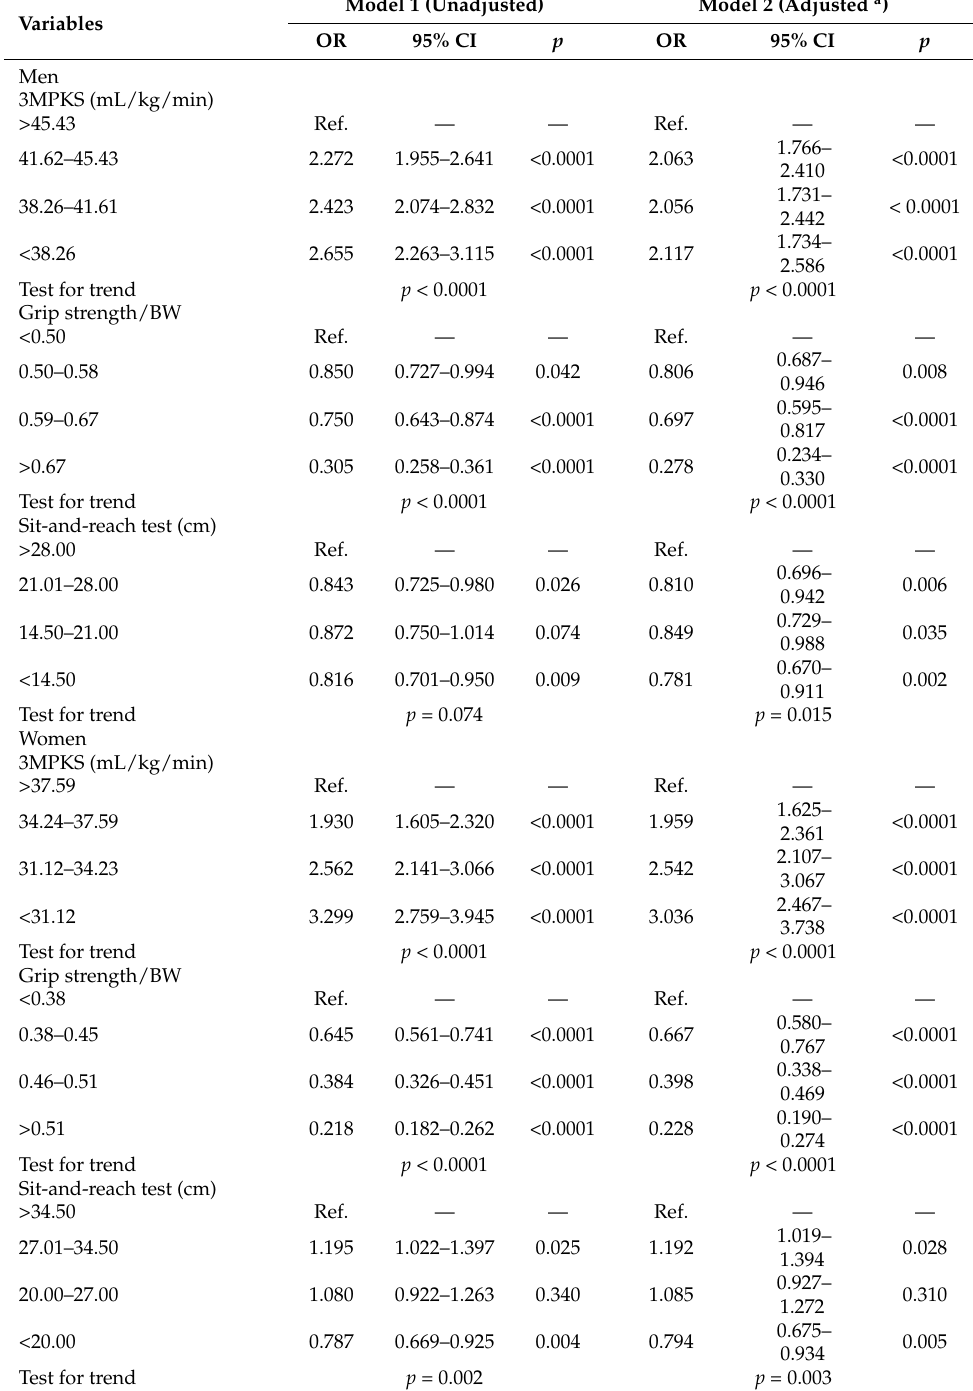
Table 5. Multivariate adjusted ORs for overweight in relation to quartiles of scientific physical fitness measurements after adjustment for potential confounders (n =